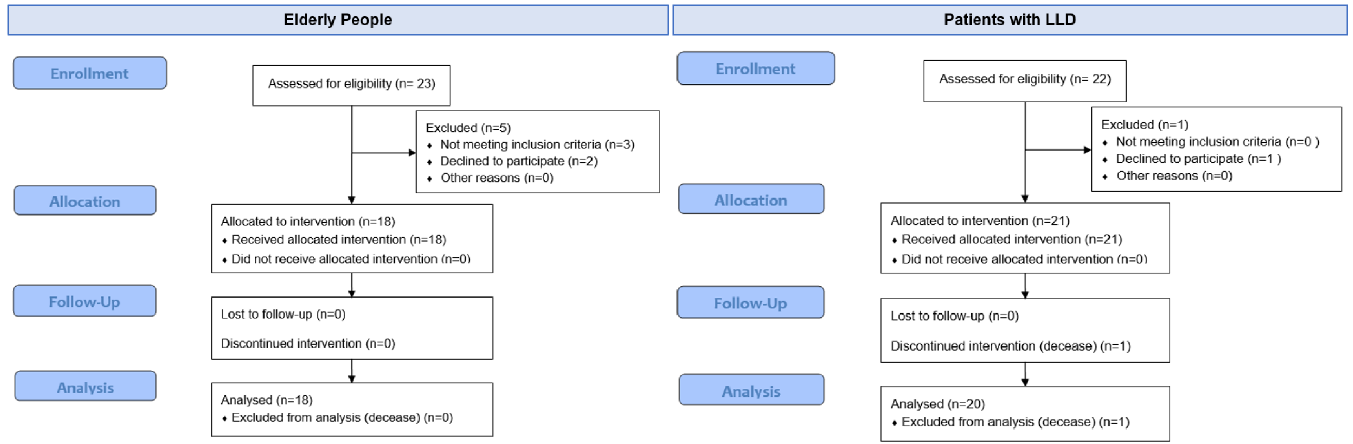
Fig 1. CONSORT flow diagrams of the elderly people from Albertia Servicios Sociosanitarios and patients with lower limb disorders from Lescer Clinic.